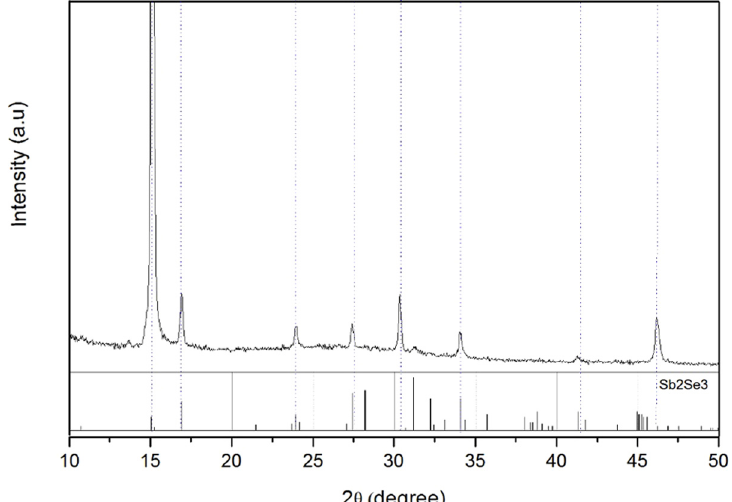
Fig. 5. XRD pattern of Sb 2 Se 3 :I fi lm on BK7 after heat treatment at 272 ° C. The diffraction peaks can be assigned to the orthorhombic phases for Sb 2 Se 3 (JCPDS 75-1462).